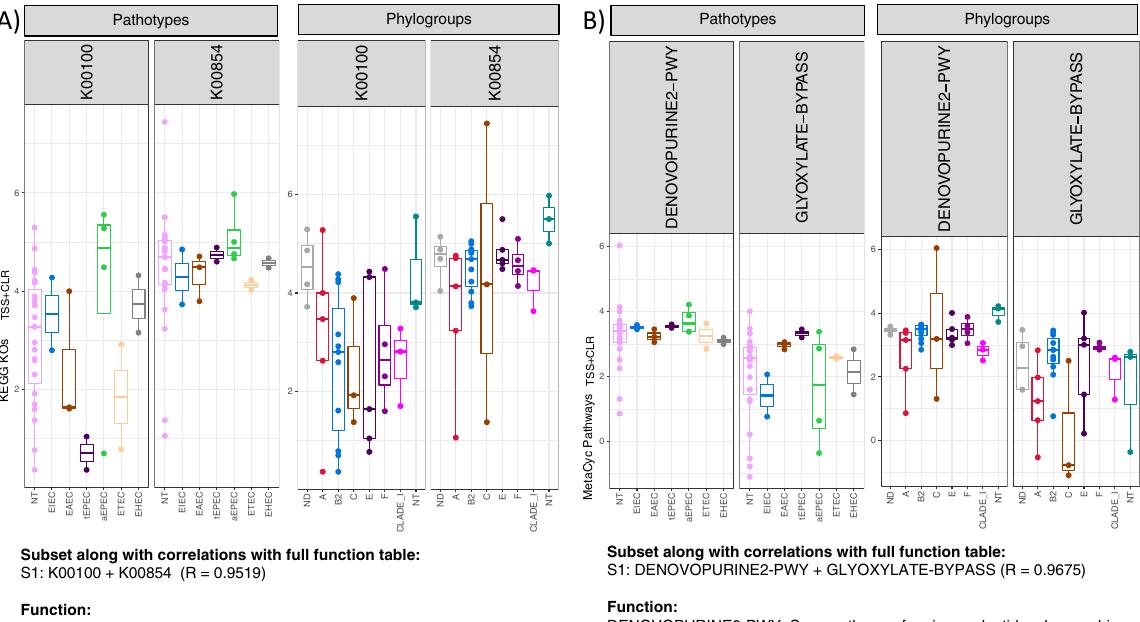
Subset along with correlations with full function table: S1: DENOVOPURINE2-PWY + GLYOXYLATE-BYPASS (R = 0.9675) S1: K00100 + K00854 (R = 0.9519) Function: DENOVOPURINE2-PWY: Superpathway of purine nucleotides de novo biosynthesis II K00100: Butanol dehydrogenase [EC:1.1.1.-] GLYOXYLATE-BYPASS: Glyoxylate cycle K00854: Xylulokinase [EC:2.7.1.17] Figure 5. Expression of significant KEGG Orthologs KOs ( A ), and MetaCyc pathways ( B ) identified from the BVSTEP routine with samples organized under a given convention, whether it is pathotypes or phylogroups. For the given data, only one subset was returned with > 0.95 correlation with further details including correlation values given below the